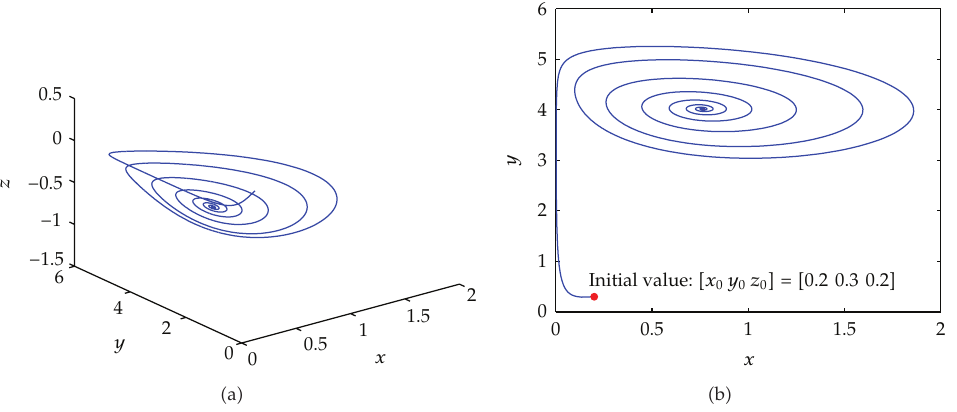
Figure 5: The numerical solutions of Example 4.2 with initial value (cid:3) x 0 ,y 0 ,z 0 (cid:4) (cid:7) (cid:3) 0 . 2 , 0 . 3 , 0 . 2 (cid:4) and step size h (cid:7) 0 . 02: stable equilibrium point (cid:3)(cid:3) a (cid:4) 3D portrait; (cid:3) b (cid:4) x - y projection (cid:4)